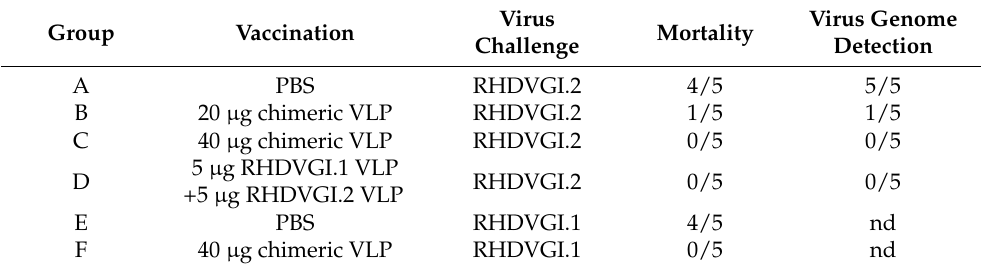
Table 2. Rabbit protection results obtained with different vaccine formulations after challenge of vaccinated rabbits with the two RHDV serotypes.